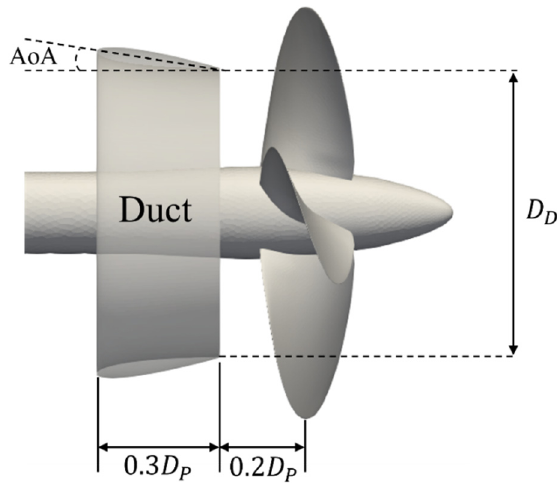
Figure 1. Propeller and duct configuration.